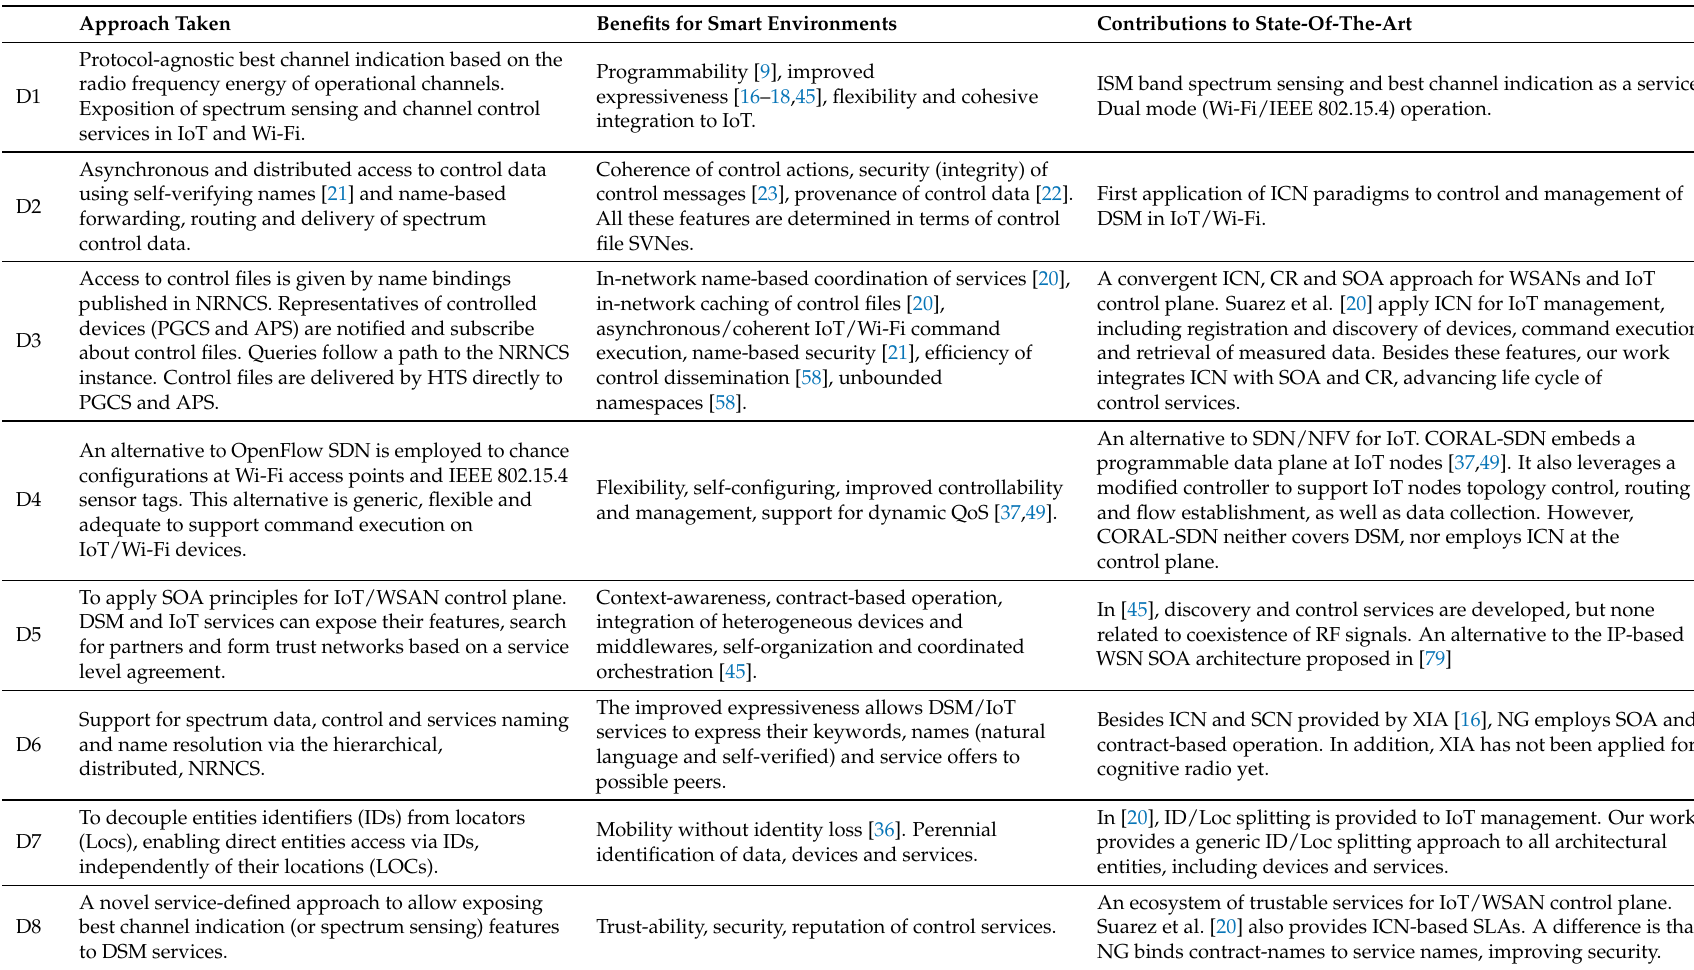
Table 5. NovaGenesis DSM for IoT/Wi-Fi. D1— Dynamic spectrum management with cognitive radio; D2—Secure exchange of control data via trustable services; D3—Named-control-data access and routing; D4—Software-defined control and operation; D5—Dynamic composition of control services; D6—Improved naming and name resolution for IoT; D7—Identifier/locator splitting for architecture entities; D8—Contract-based control